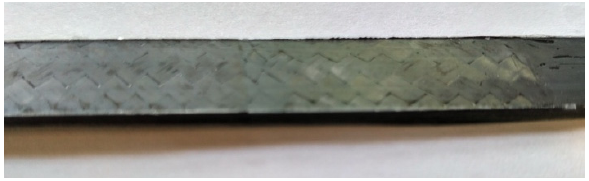
Figure 11. ±45° carbon twill ply.